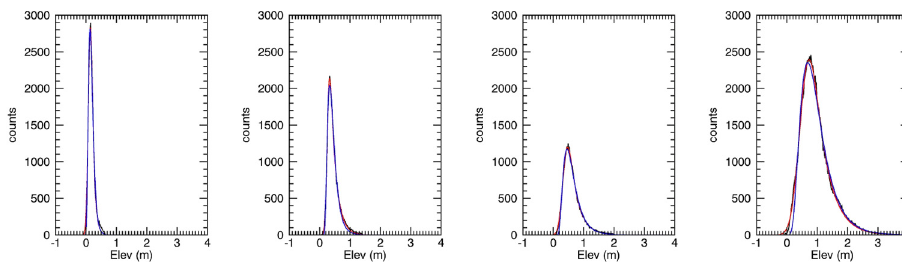
Figure 6. Examples of lognormal (blue) and EMG (red) pdf fitting.